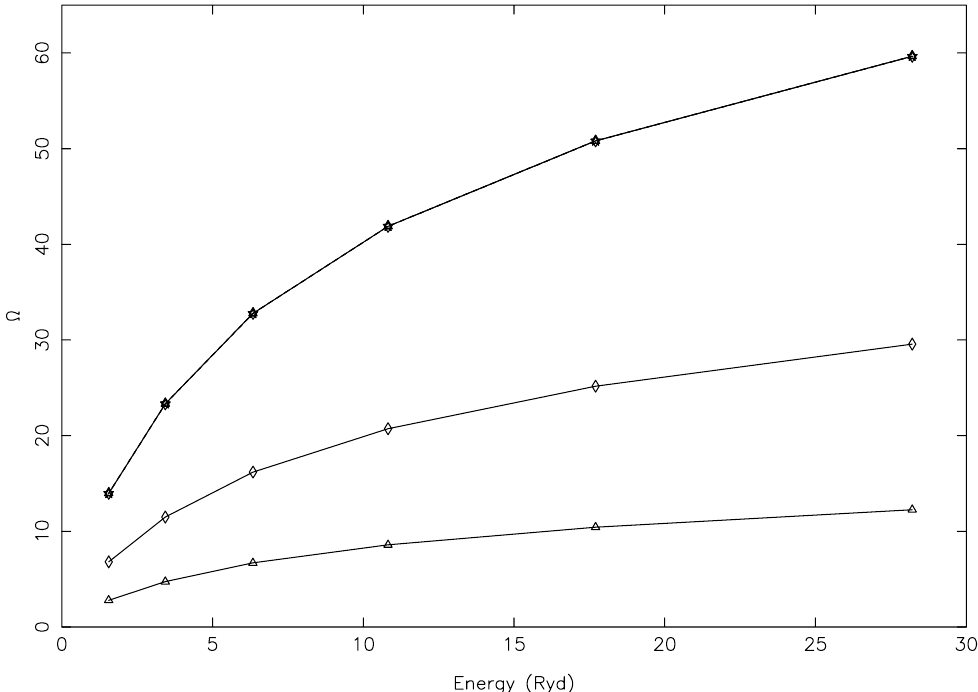
Figure 1. Our calculated values of Ω with FAC for the 1–25 (triangles: 3p 2 3 P 0 –3p3d 3 D o (diamonds: 3p 2 3 P 1 –3p3d 3 D o